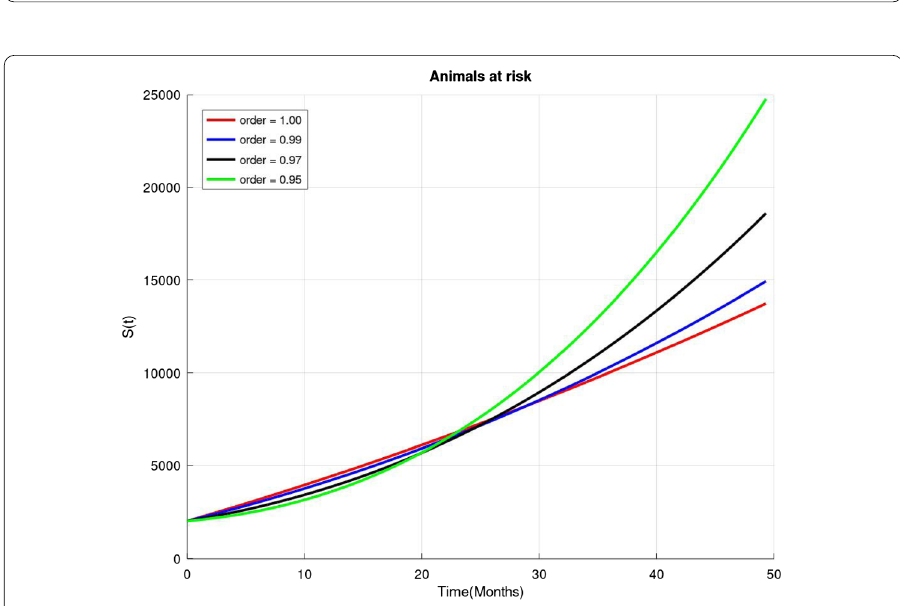
Figure 2 An illustration of the total number of susceptible animals S ( t ) for different orders (cid:2) = 1, (cid:2) = 0.99, (cid:2) = 0.97, and (cid:2) = 0.95 during 50 months